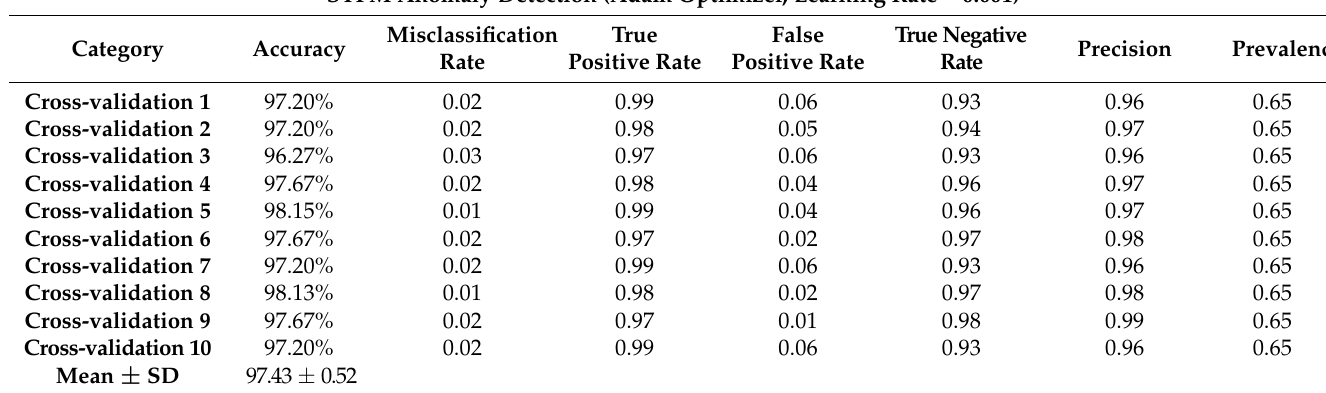
Table 3. Misclassification rate, accuracy, false positive rate, true negative rate, true positive rate, prevalence, precision, standard deviation of accuracy, and mean.